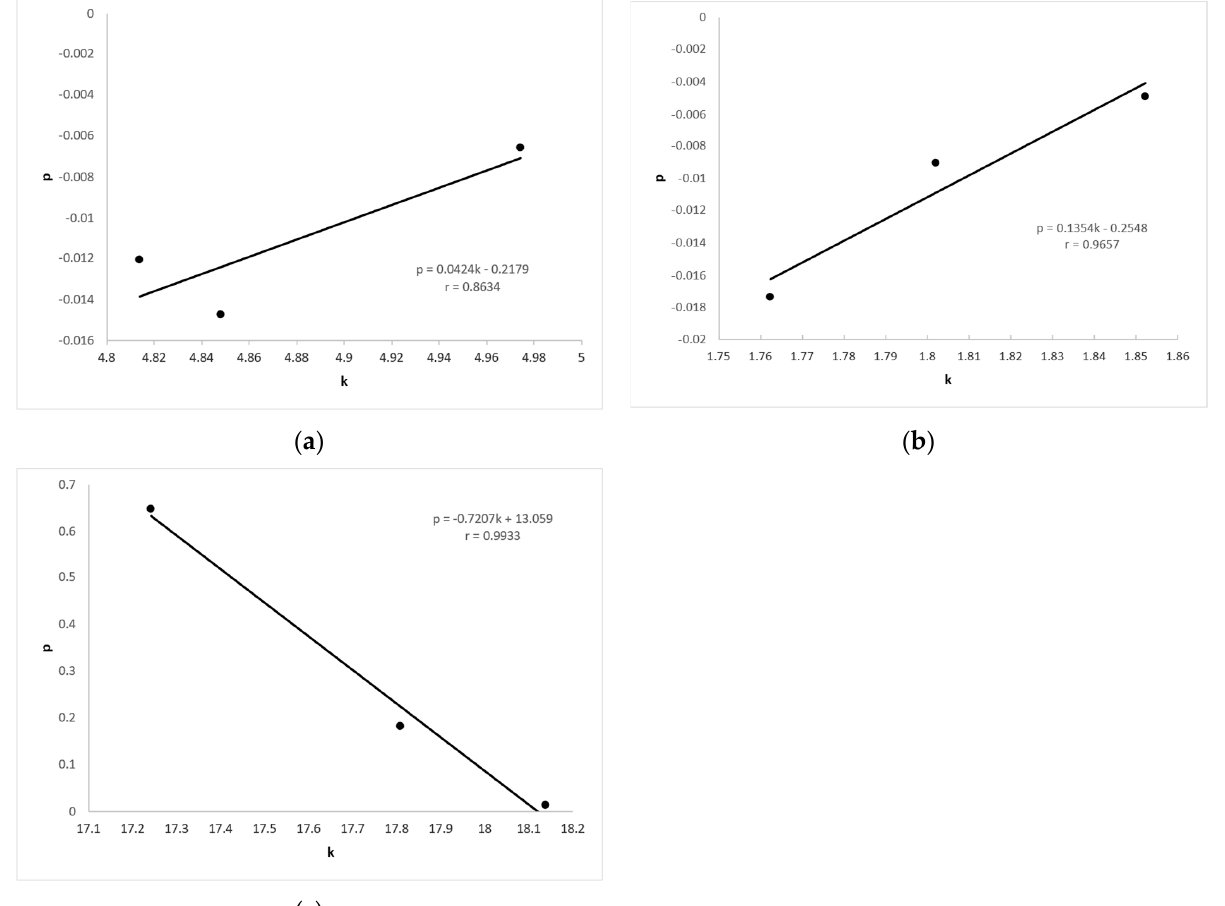
Figure 9. Correlation between the slope of the line k of force and the slope of the line p of electric resistance for samples: ( a ) X-0, Y-0, and Z-0; ( b ) X-45, Y-45, and Z-45; and ( c ) X-90, Y-90, and